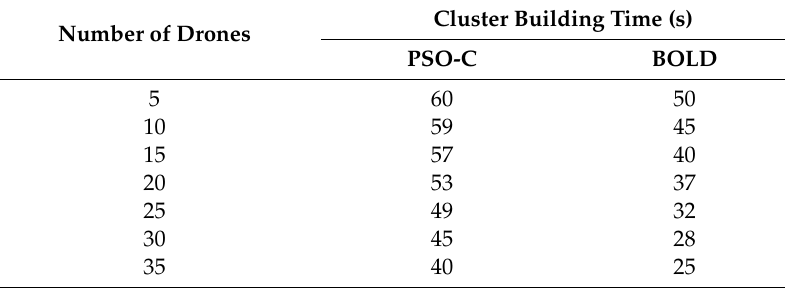
BOLD Figure 16. Cluster building time vs number of drones. Figure 16. Cluster building time vs number of drones. Table 8. Cluster building time vs the number of Table 8. Cluster building time vs the number of drones.